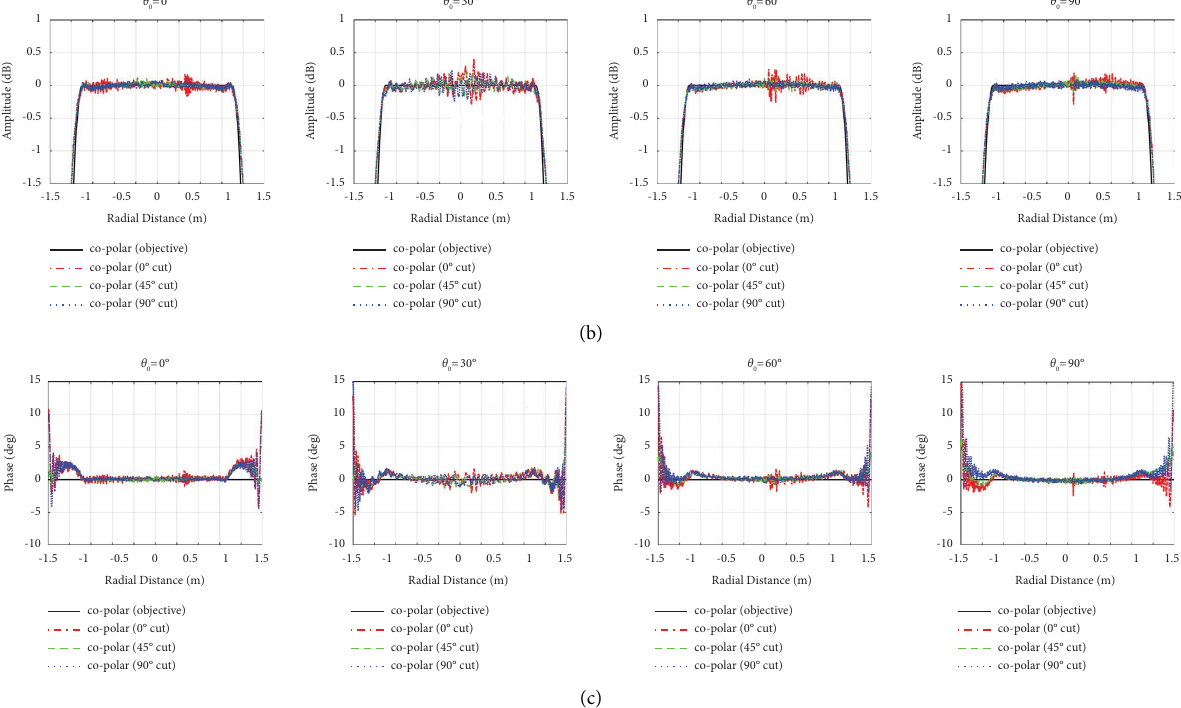
Figure 7: PO +PTD one-dimensional normalized simulation results of the designed tri-refector CATRs with diferent feed rotation angles at 300GHz. (a) Cross-polar isolation, (b) copolar amplitude, and (c) copolar